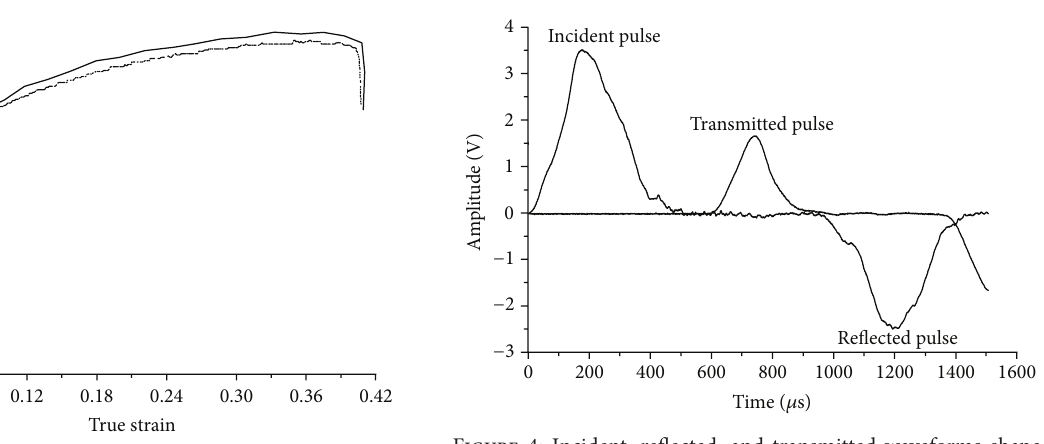
Figure 4: Incident, reflected, and transmitted waveforms shaped with a brass pulse shaper ( 𝜙20 × 1 mm) for a NAC specimen under the striking velocity of 8.95 m/s.